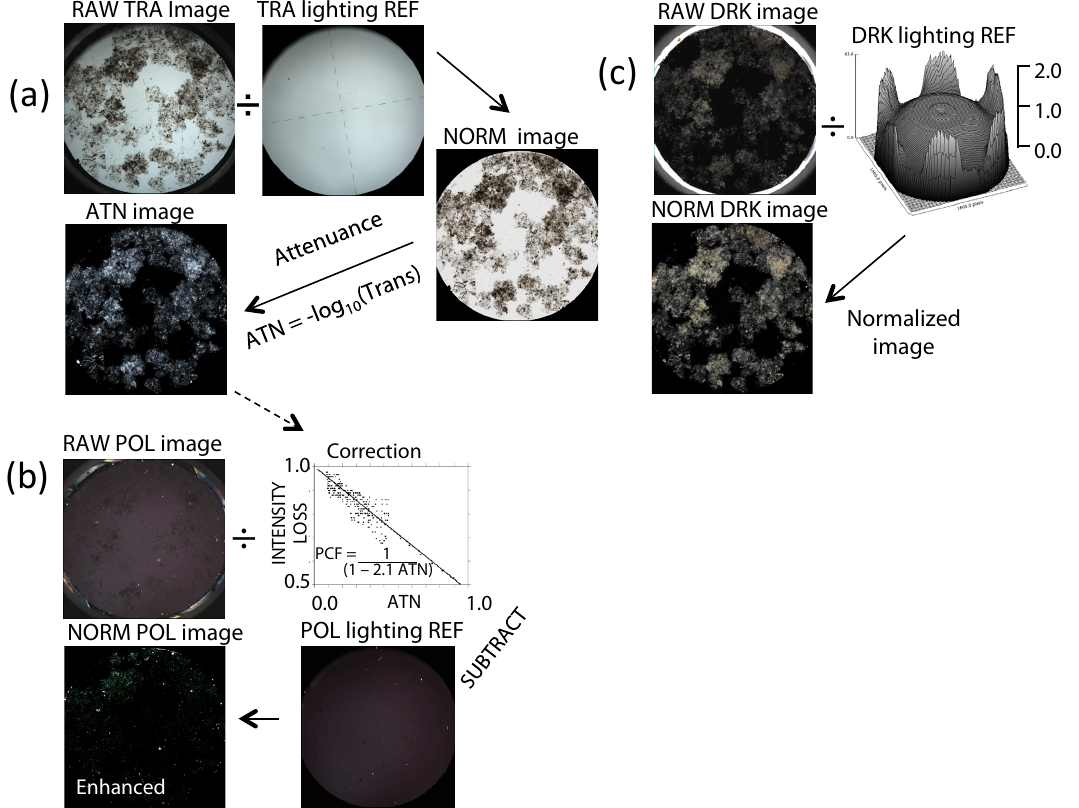
Figure 2. Detail of image analysis scheme for CFE and BUOY-OSR images. Images from NH1301 CFE001 deployment. Panel (a) : raw backlit (TRA) images are divided by the in situ TRA lighting reference (cross-hair reticle has 1mm sized dashes) to get transmittance. This image is transformed to units of attenuance. Panel (b) : raw crossed polarized transmitted light (POL) image is first corrected for attenuation effects of optically dense particles by dividing by PCF, an empirically derived factor proportional to attenuance (ATN). The POL lighting REF is then subtracted and intensity normalized by the TRA lighting REF to yield the NORM POL image. The contrast and brightness of the final image is enhanced. Panel (c) : raw dark field (DRK) images are normalized by dividing by the in situ lighting reference intensity.